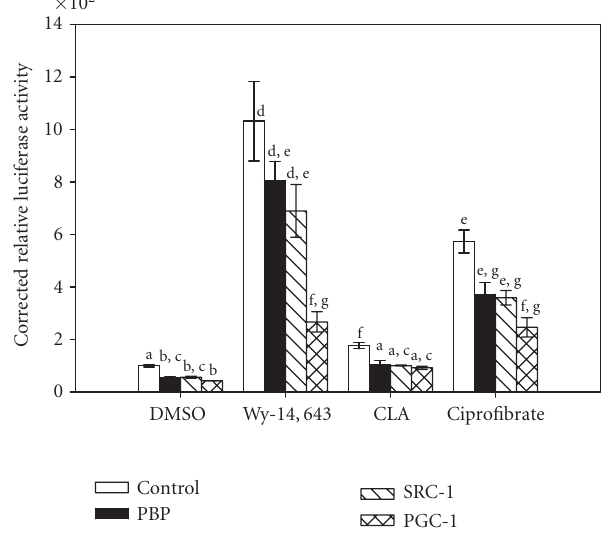
Figure 2: Inhibition of coactivator expression by RNAi decreases PPAR α activity in a ligand-specific manner. 3T3L1 cells were tran- siently transfected with pM/PPAR α , GAL4 responsive reporter, pRLTK, and appropriate RNAi vector or empty vector control. Cells were treated with 50 μ M Wy-14,643, 100 μ M CLA, 100 μ M ciprofi- brate, or DMSO for 6 hours. Luciferase activity was measured and corrected for transfection e ffi ciency and extraction yield ( n = 3). Values are expressed corrected to untreated empty vector control bar (100%). Bars with di ff erent letters above are significantly di ff er- ent from each other (Tukey’s multicomparison test, P < . 05), repre- sentative of 2 independent experiments.